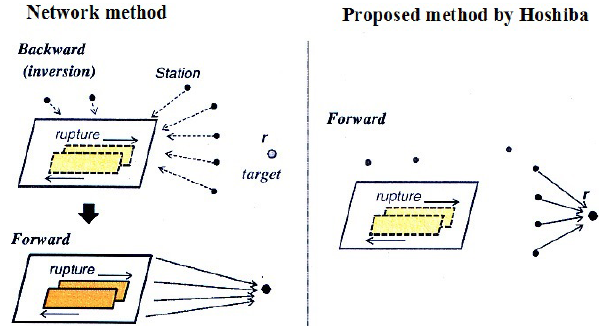
Figure 2. Comparison of the method proposed by Hoshiba with the network method (modified after Hoshiba,